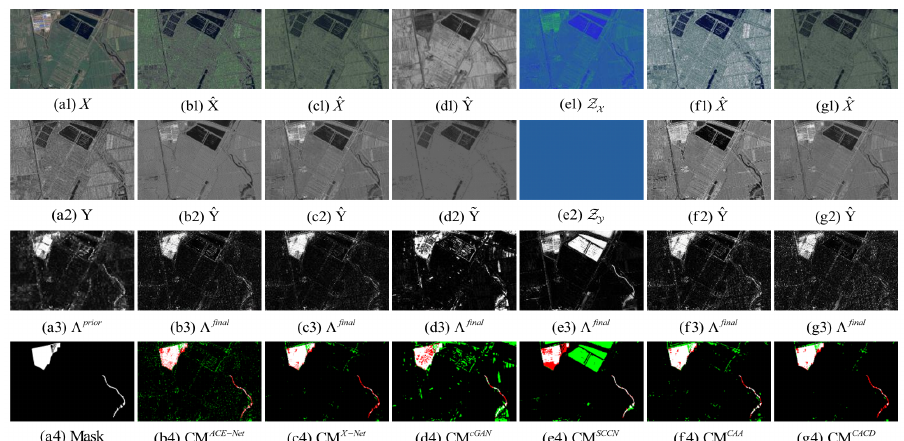
Figure 10. Shuguang dataset. ( a1 ) Input image X . ( a2 ) Input image Y . ( a3 ) Prior difference matrix generated by IRG-McS. ( a4 ) Real mask. ( b – g ) represent the results of ACE-Net, X-Net, cGAN, SCCN, CAA and CACD (US) methods, respectively. ( b1 , c1 , f1 , g1 ) transformed image ˆ X . ( d1 ) transformed Y domain image ˆ Y . ( e1 ) code image Z X . ( b2 , c2 , f2 , g2 ) transformed image ˆ Y . ( d2 ) approximate Y domain image ˜ Y . ( e2 ) code image Z Y . ( b3 , c3 , d3 , e3 , f3 , g3 ) final difference map. ( b4 , c4 , d4 , e4 , f4 , g4 ) confusion map, where white: true positives (TP), black: true negatives (TN), green: false positives (FP), red: false negatives (FN).